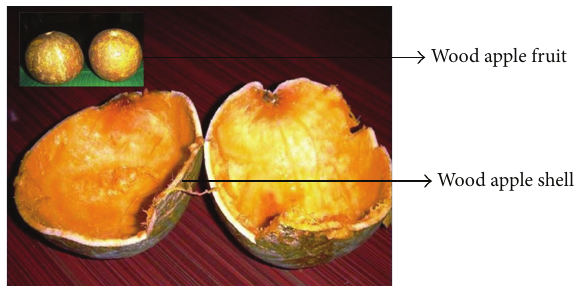
Figure 1: Wood apple shell.